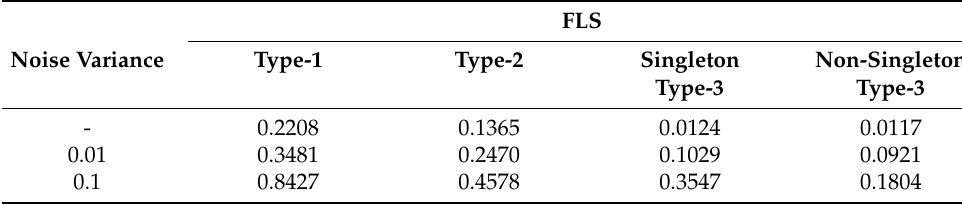
Table 2. Comparison the effect various